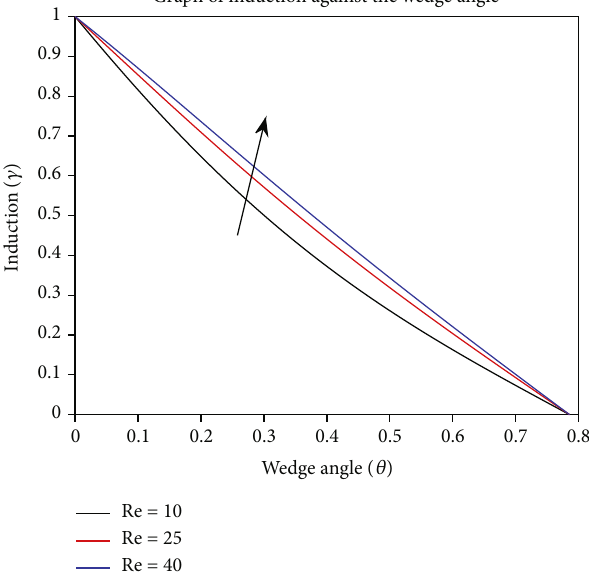
Figure 7: E ff ect of varying the Reynolds number on magnetic